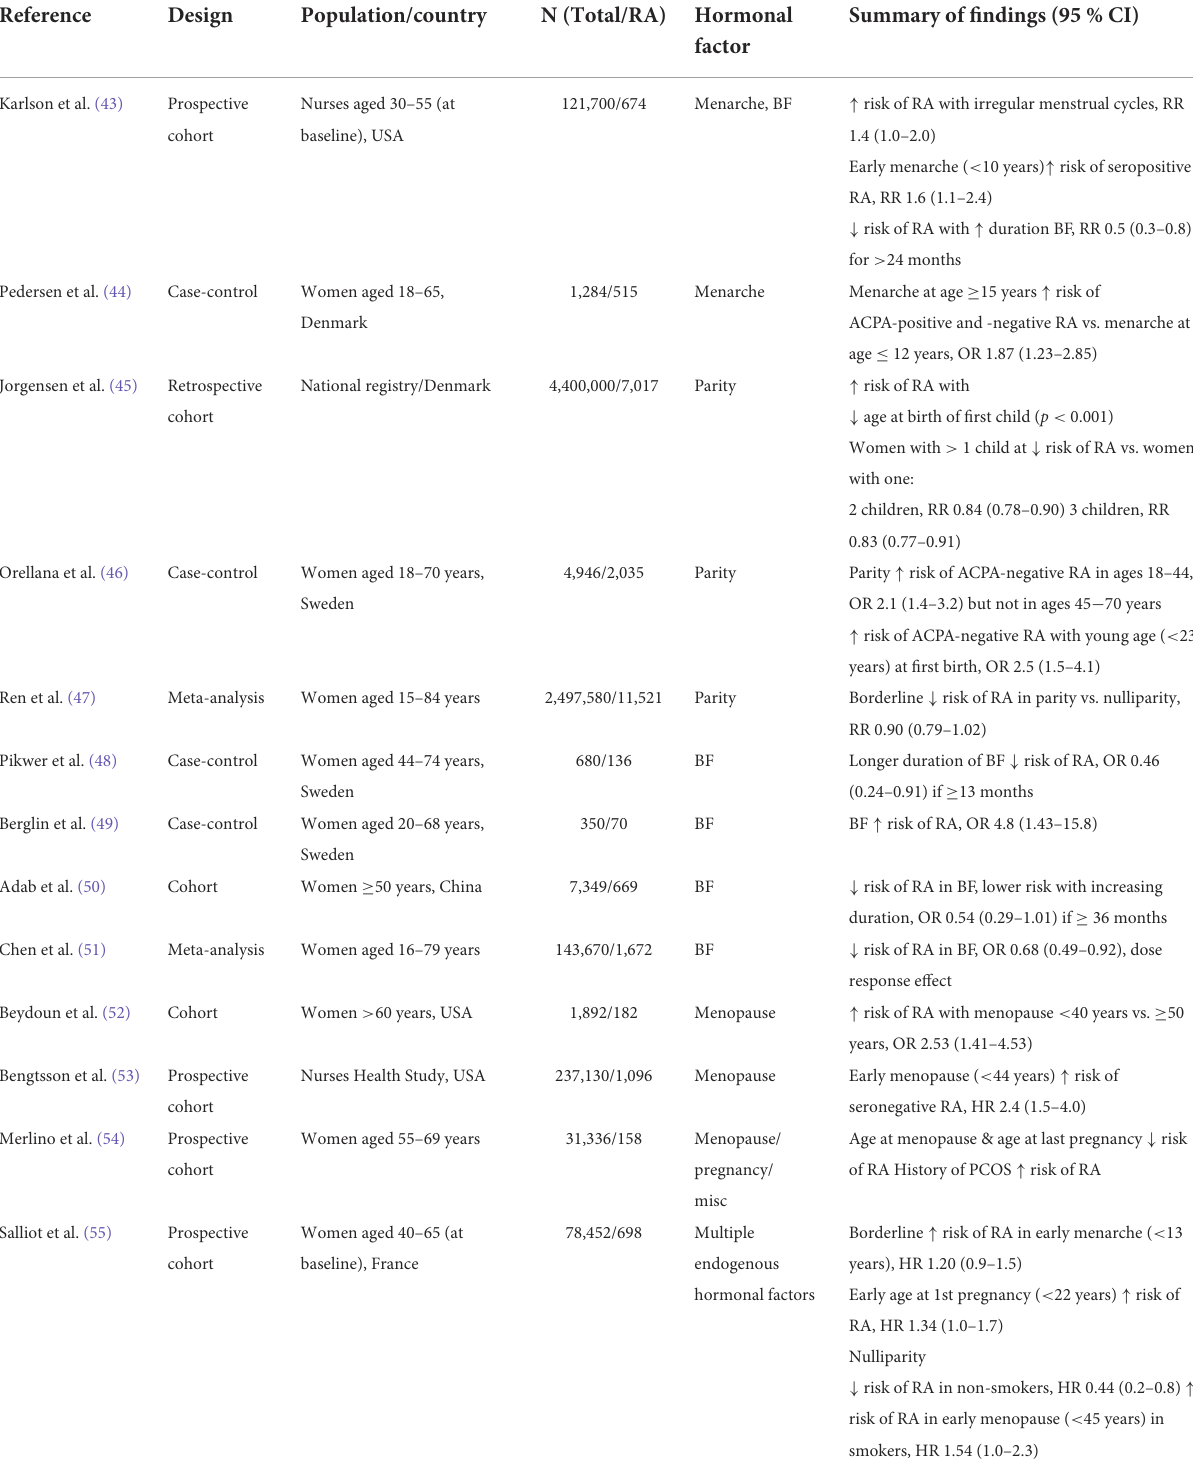
TABLE 1 Epidemiological studies showing an association between endogenous sex hormones and rheumatoid arthritis